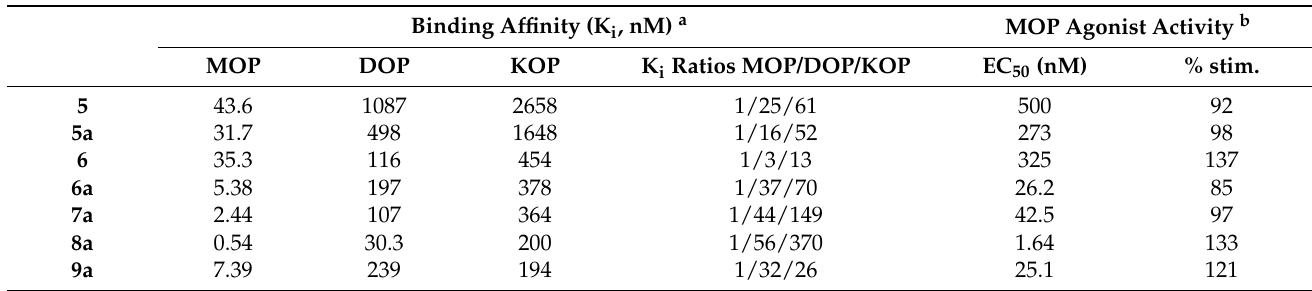
Scheme 5. Synthetic route to 6,7-didehydrocarbonitrile 9a . Reagents and conditions: ( a ) TosMIC, t -BuOK, DME, t -BuOH, 0 ◦ C.